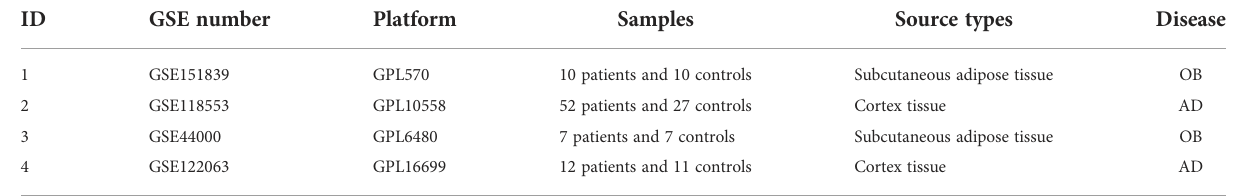
TABLE 1 Summary of those four GEO datasets involving OB and AD